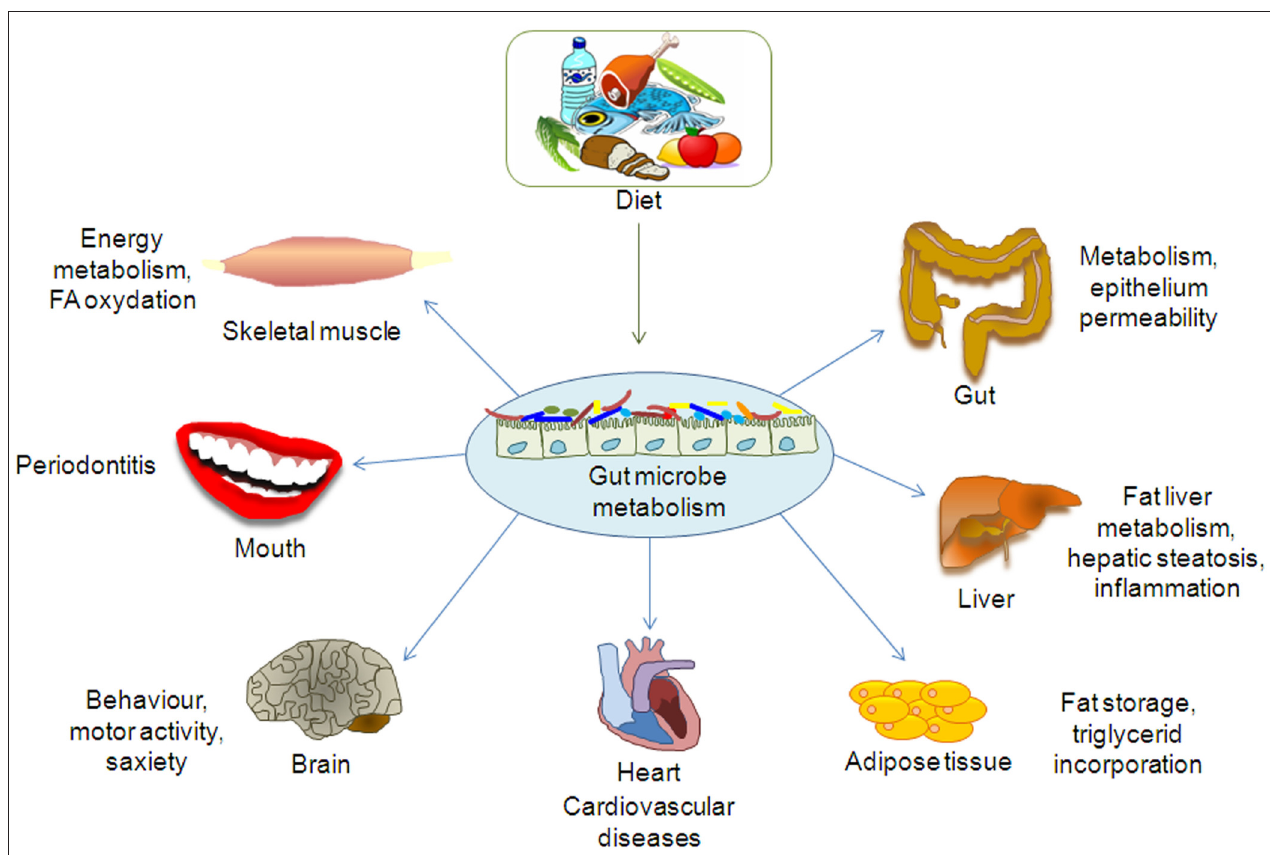
FIGURE 1 | Effect of gut microbiota metabolome on organs and tissues.